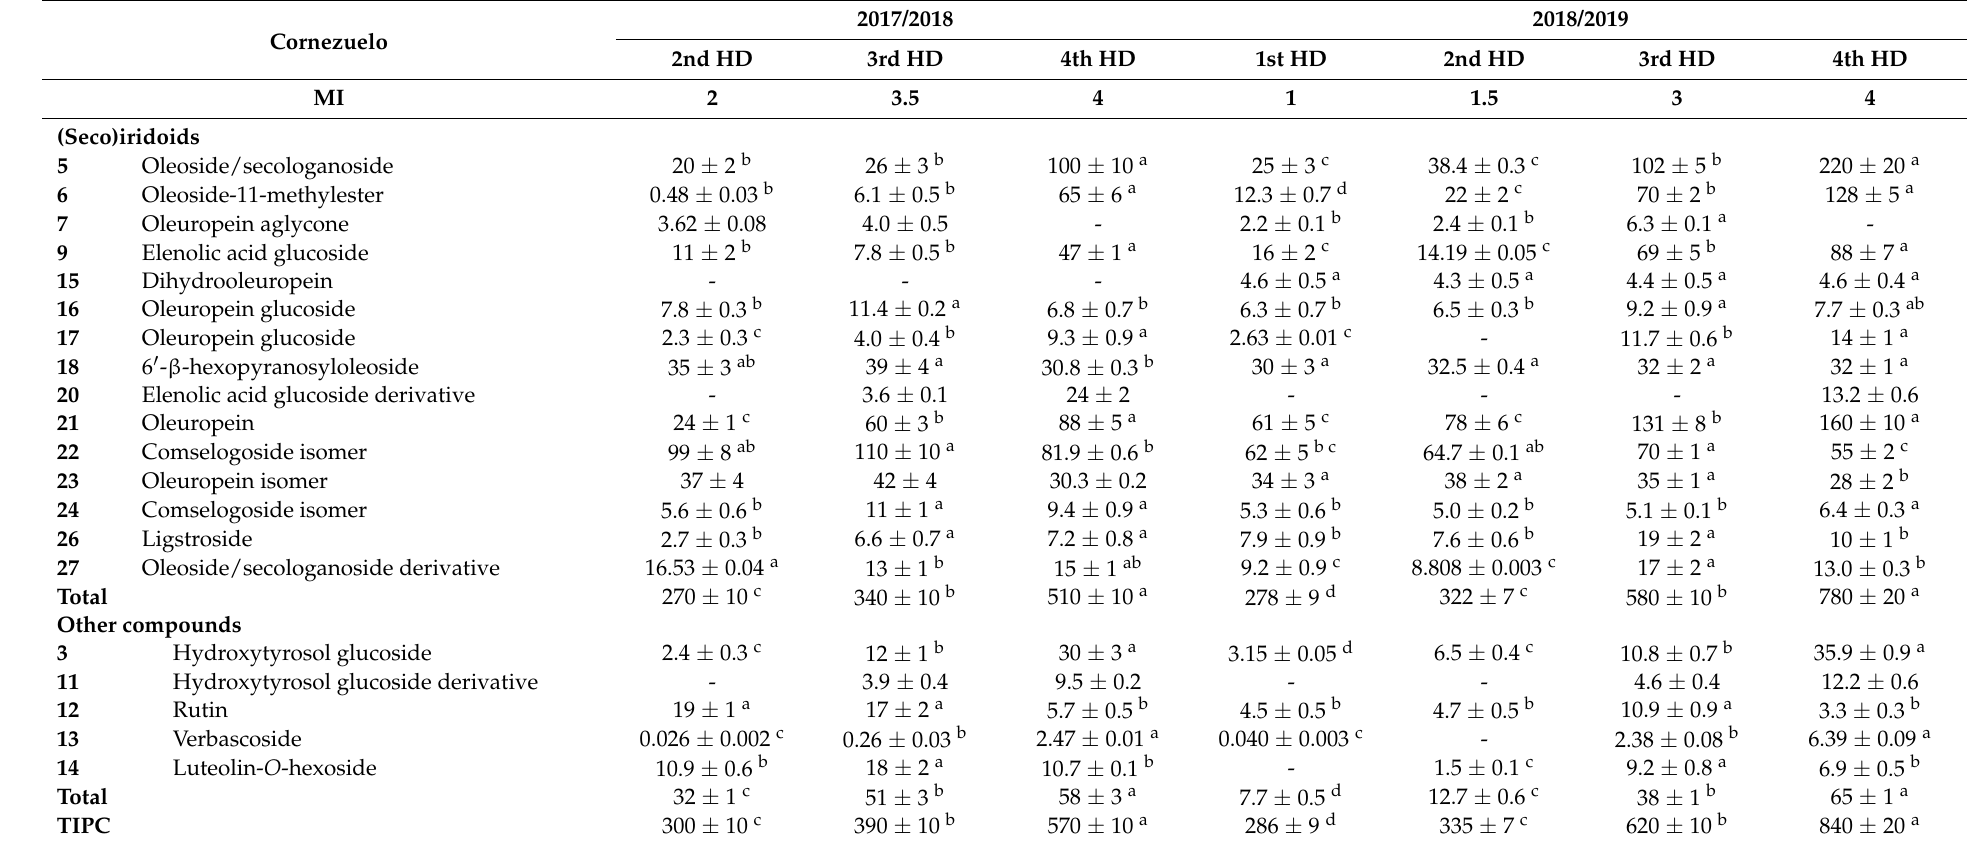
Table 2. Quantification of phenolic compounds in olive fruits (cv. Cornezuelo) at different harvest times and harvest seasons.